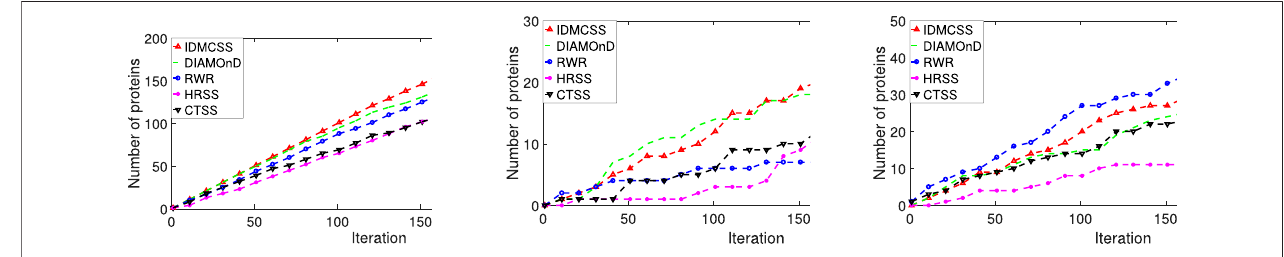
FIGURE 4 | Performance of IDMCSS, CTSS, DIAMOnD, RWR and HRSS on the asthma dataset. GO annotations: the number of asthma-related GO annotations enriched in the disease module; DifferExpre: the number of differential expressed genes in the disease module; Pathways: the number of asthma-related pathways enriched in the disease